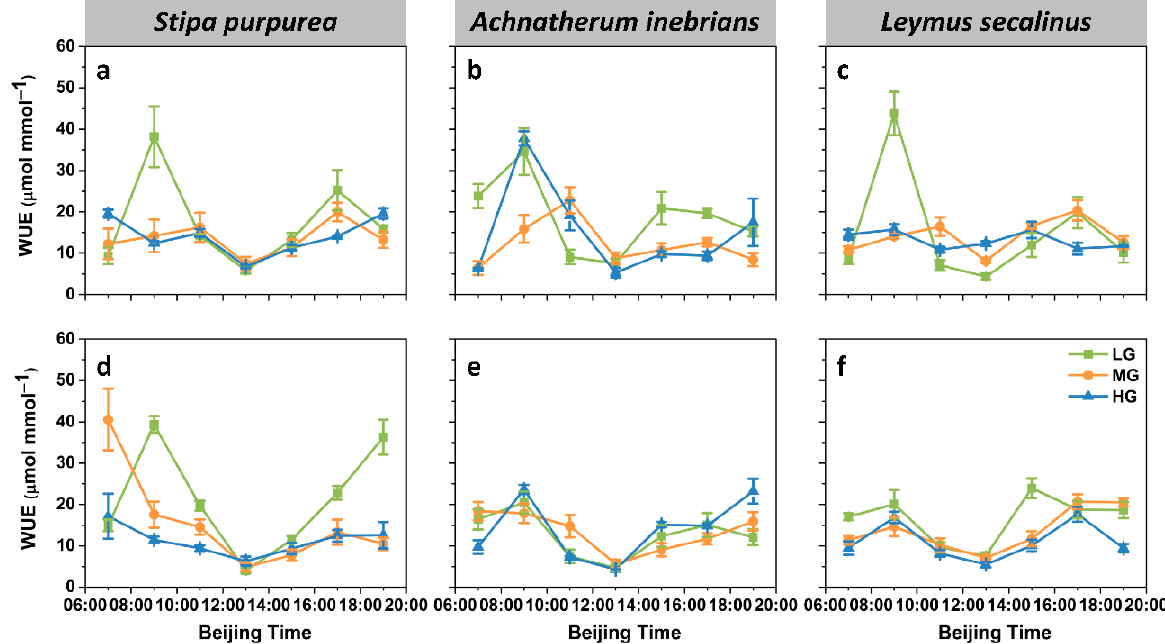
Figure 6. Diurnal dynamics of the water use efficiency (WUE) of the leaves and spikes of S. purpurea ( a , d ), A. inebrians ( b , e ) and L. secalinus ( c , f ) in response to grazing intensity (LG, light grazing; MG, medium grazing; HG, heavy grazing). The data are presented as mean ± standard error (SE) of three independent experiments.